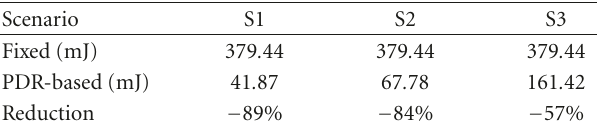
Table 1: Quantitative comparison of expected energy emission for the updating phase: IEEE